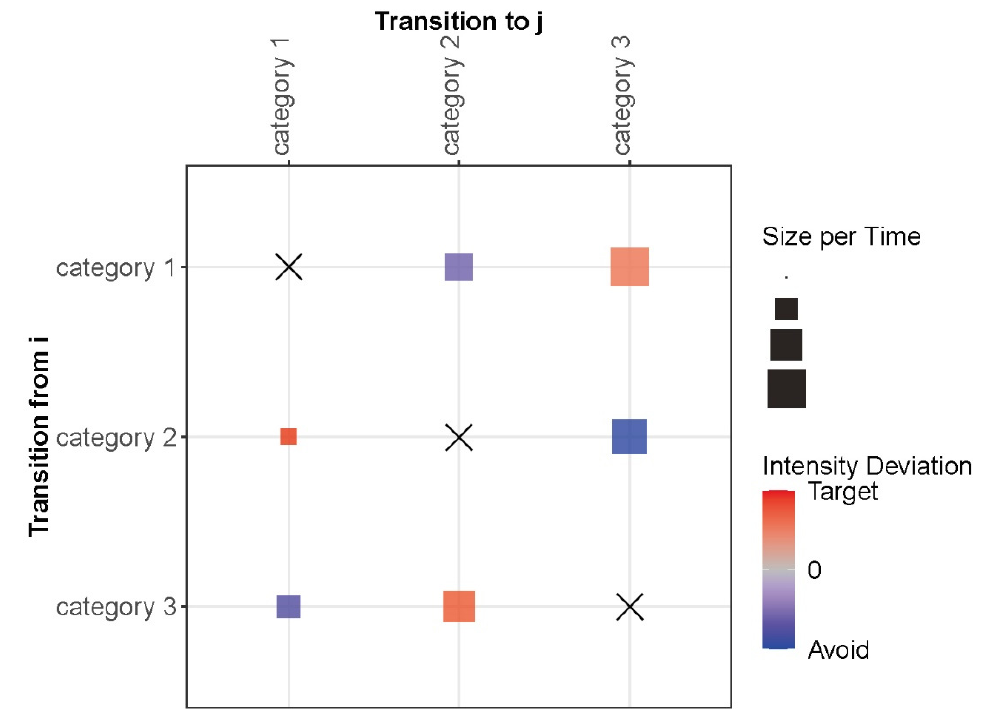
Figure 3. Structure of transition pattern. The intensity deviation refers to the deviation between the transition intensity R tij of a specific off-diagonal entry and the column’s uniform transition intensity W tj . The supplementary materials section provides the equations for R tij and W tj . Readers should compare the colors within a column to see how each column gains category targets or avoids each row’s losing category. “×” means no transition between the same land use types during two periods.